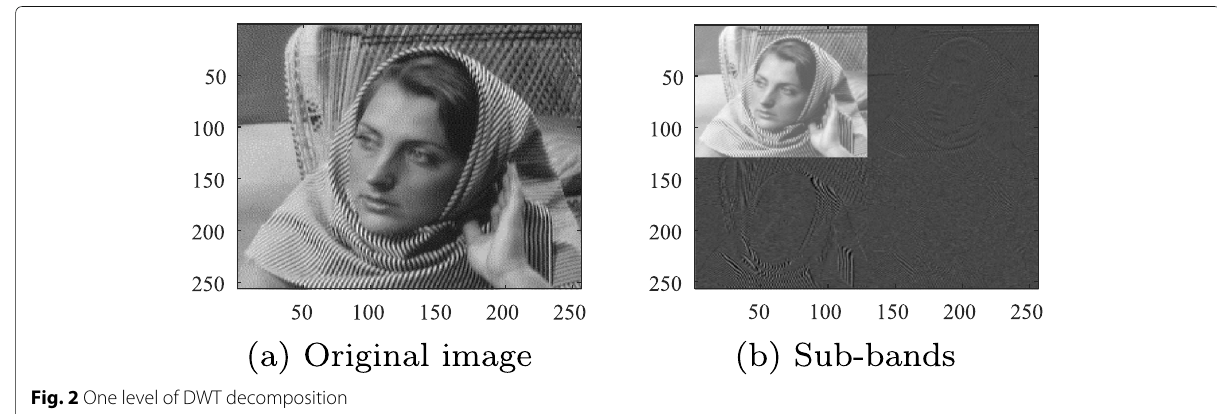
Fig. 2 One level of DWT